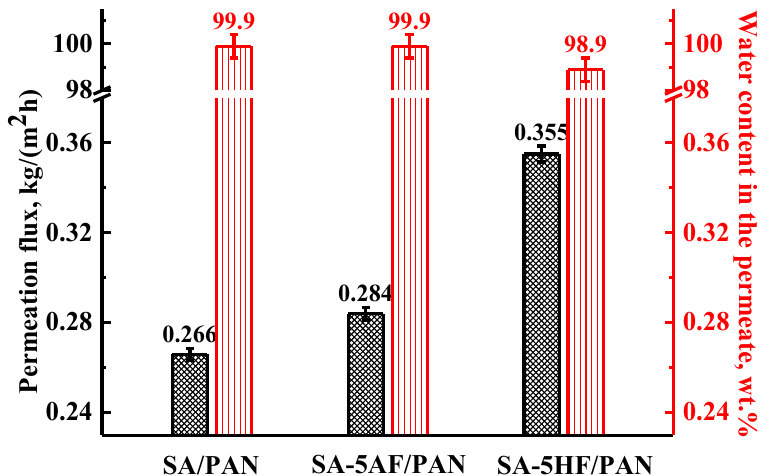
Figure 2. Permeation flux and water content in the permeate for the untreated PAN-supported membranes based on SA, SA-AF (5%), and SA-HF(5%) composites in the pervaporation separation of an azeotropic water/isopropanol (12/88 wt.%) mixture at 22 °C. It was demonstrated that the bulk modification of the untreated PAN-supported SA membrane with AF and HF nanoparticles (SA-5AF/PAN and SA-5HF/PAN) increased per- meation flux by 7 and 33%, respectively, for the pervaporation separation of an azeotropic water/isopropanol (12/88 wt.%) mixture. At the same time, a slight decrease in the